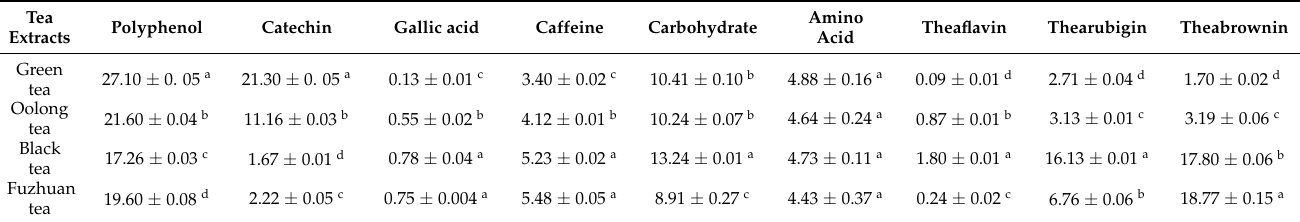
Table 3. The main constituents of different tea extracts (%).